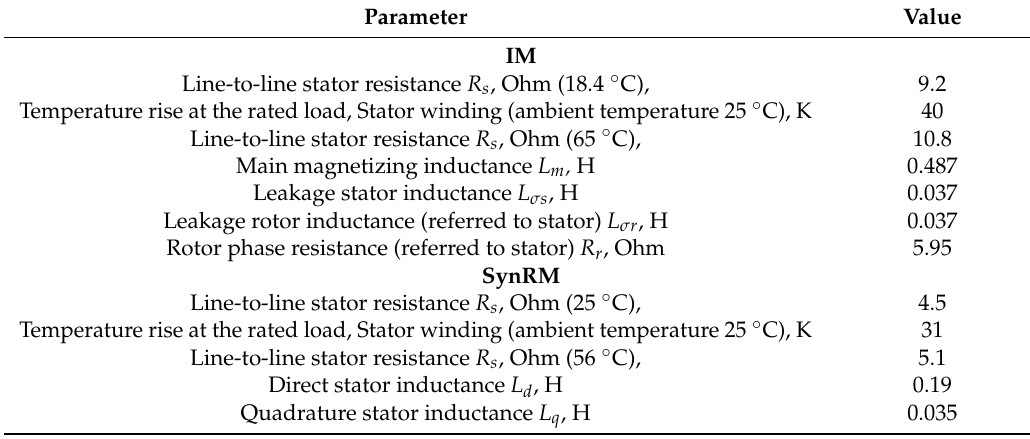
Table 8. Electrical parameters of 1.1 kW, 3000 rpm